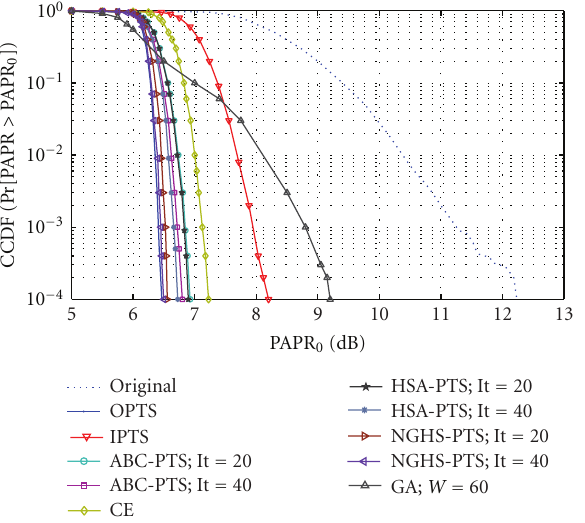
Figure 3: Zoomed version of Figure 2 around CCDF = 10 − 4 .